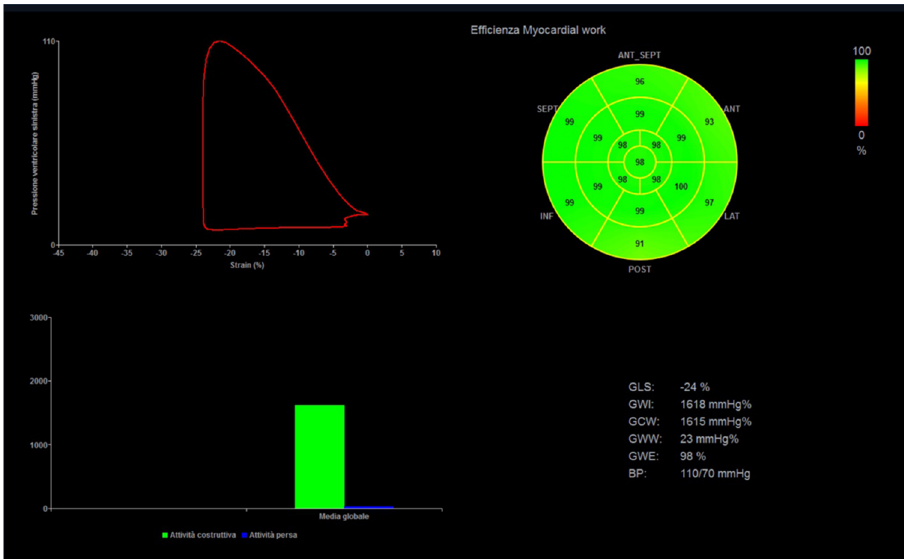
Figure 2. Myocardial work analysis in a power athlete (bodybuilder). On the left, left ventricular pressure–strain loop, showing the relationship between left ventricular systolic pressure and global longitudinal strain. On the right, the 17-segment bull’s-eye representation of myocardial work efficiency, showing homogeneous areas of high efficiency coded in green.